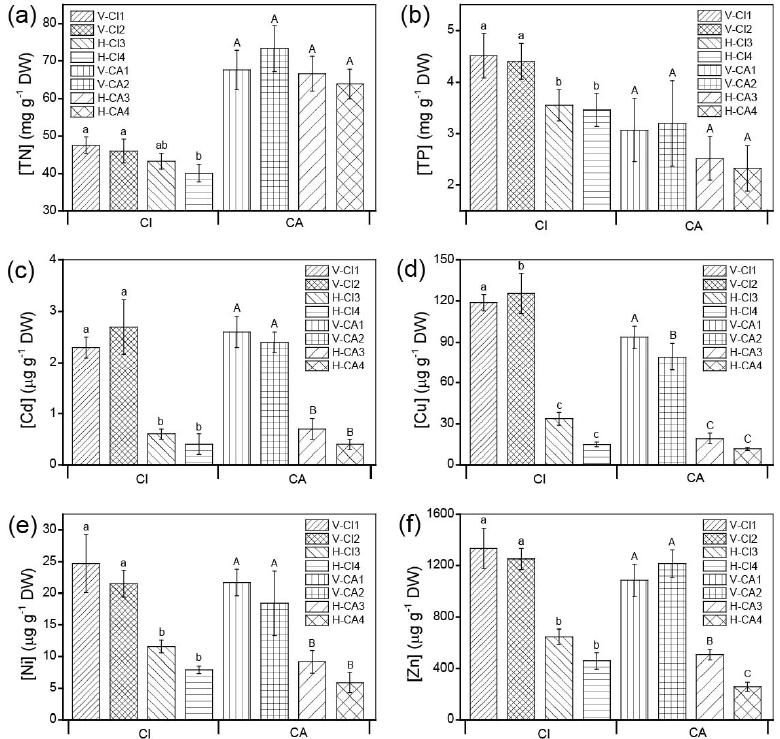
Figure 6. Nutrients concentration (mg g − 1 DW), heavy metal concentration ( µ g g − 1 DW) in roots of the two plants at the eight sites in the HCW system. (a) total nitrogen (TN); (b) total phosphorus (TP); (c) Cd; (d) Cu; (e) Ni; (f) Zn. The samples numbers were shown in Figure 1.